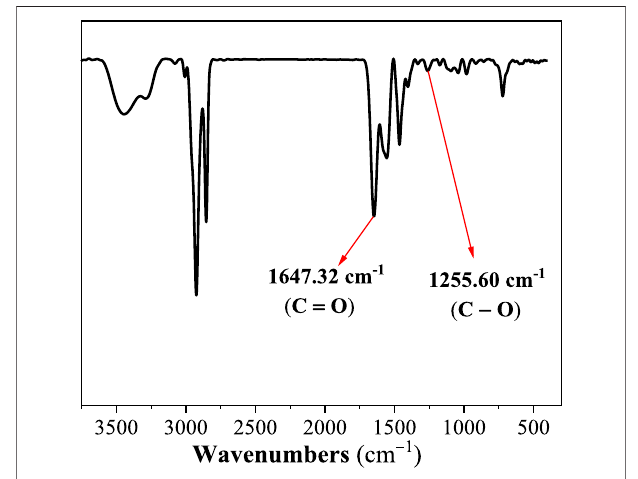
FIGURE 1 | The infrared spectrum of VES-c.